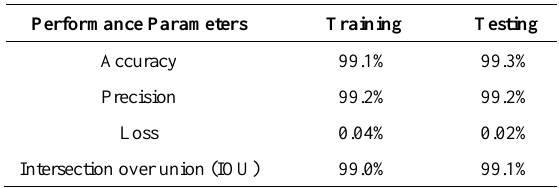
Table 3. Performance of the proposed